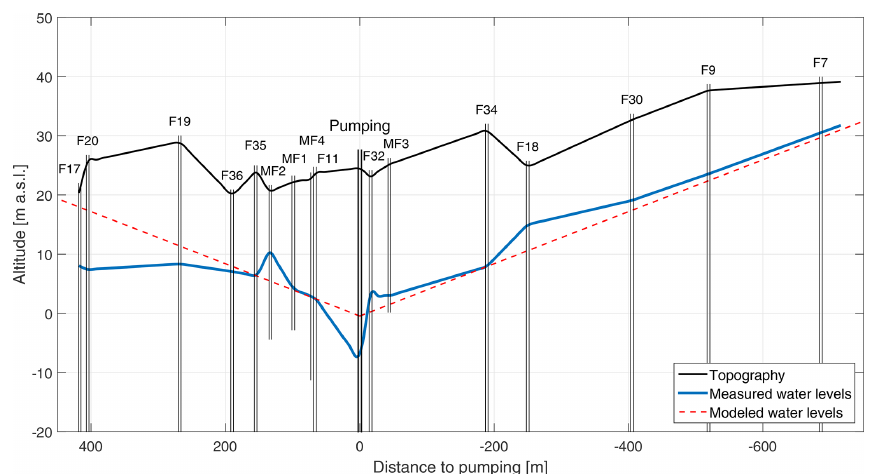
Figure C1. Mean groundwater levels observed at the Ploemeur pumping site (blue curve), shown on a SE–NW cross section. The dashed red curve represents the best 1D steady-state analytical model, which has the lowest least-square difference between data and the